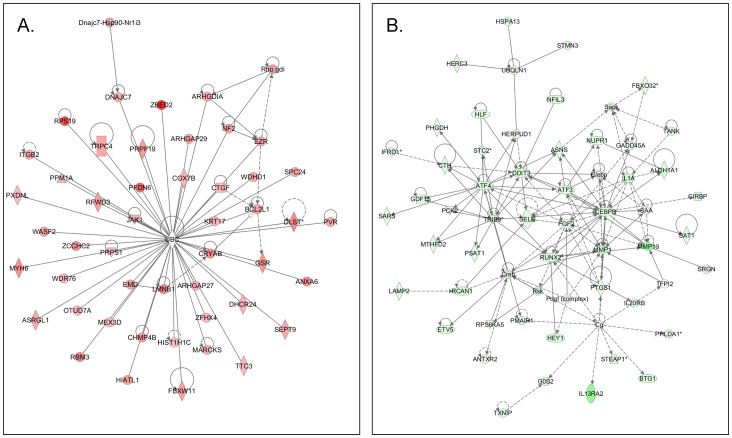
Network analysis of dynamic gene expression in SKOV3 cells based on the 2-fold common gene expression list obtained following shRNA-mediated RUNX2 knockdown.A. Upregulated networks; B. Downregulated networks. The five top-scoring networks for each cell line were merged and are displayed graphically as nodes (genes/gene products) and edges (the biological relationships between the nodes). Intensity of the node color indicates the degree of up- (red) or downregulation (green). Nodes are displayed using various shapes that represent the functional class of the gene product (square, cytokine, vertical oval, transmembrane receptor, rectangle, nuclear receptor, diamond, enzyme, rhomboid, transporter, hexagon, translation factor, horizontal oval, transcription factor, circle, other). Edges are displayed with various labels that describe the nature of relationship between the nodes: ____ binding only, → acts on. The length of an edge reflects the evidence supporting that node-to-node relationship, in that edges supported by article from literature are shorter. Dotted edges represent indirect interaction.